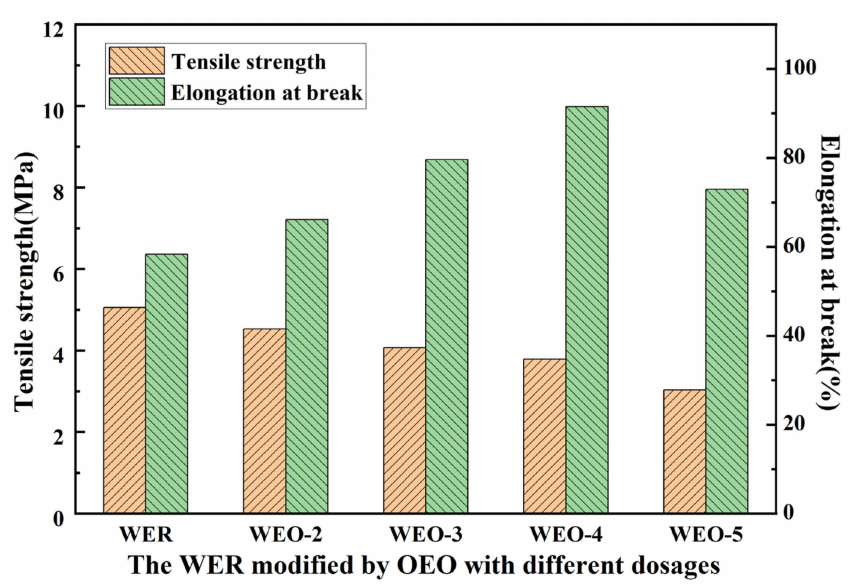
Figure 5. Mechanical properties of the cured WER and